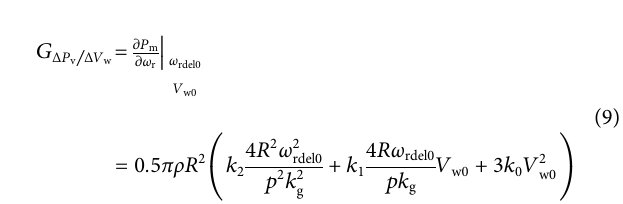
FIGURE 3 Structure of the simpli fi ed frequency response model of the power